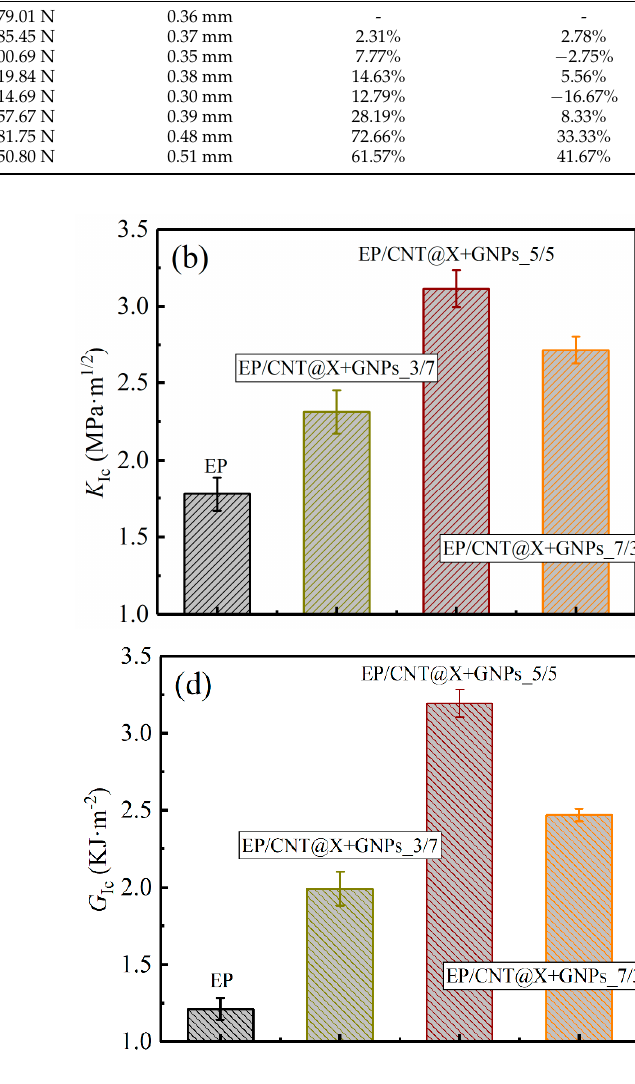
Figure 7. Quasi-static 3P-ENB fracture parameters: ( a , b ) mode-I critical-stress-intensity factor ( K Ic ) and ( c , d ) fracture energy density ( G Ic ) of the EP/GNPs and EP/CNT@X+GNPs nanocomposite specimens.